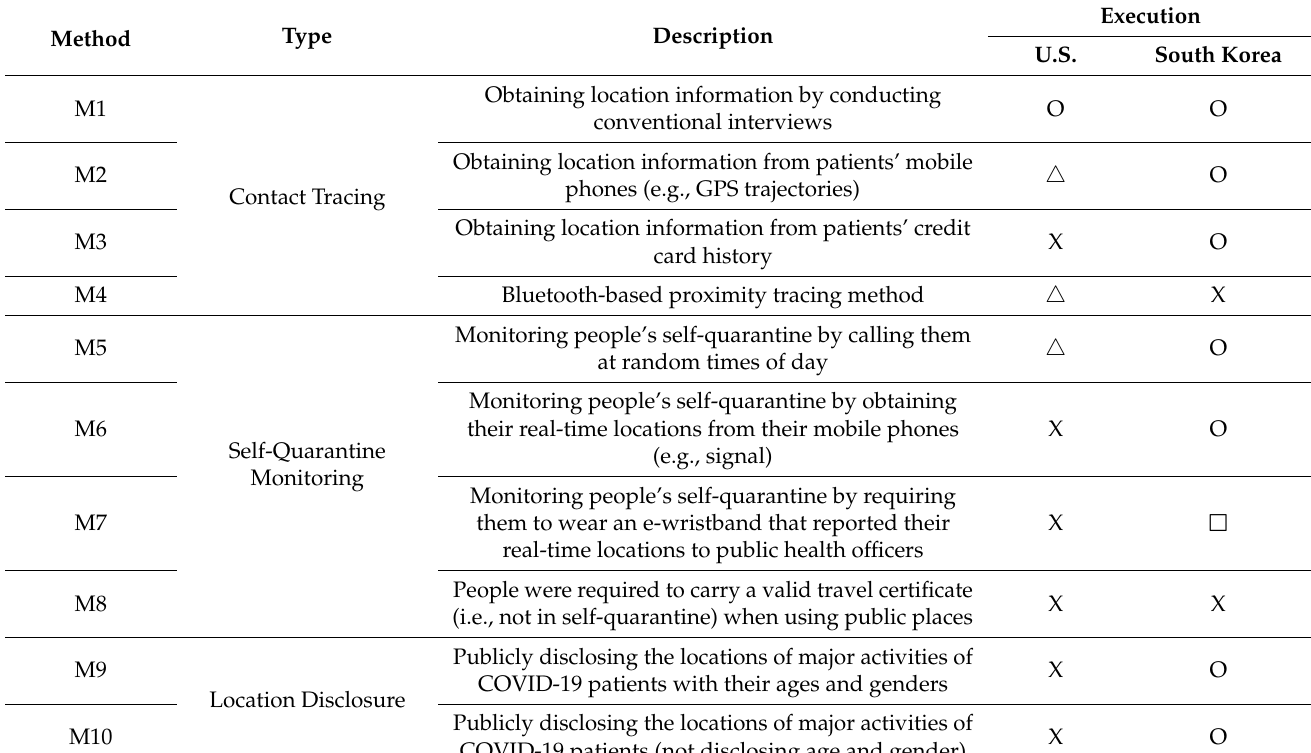
Table 2. A detailed description of the 10 COVID-19 mitigation methods harnessing location information used in the survey.